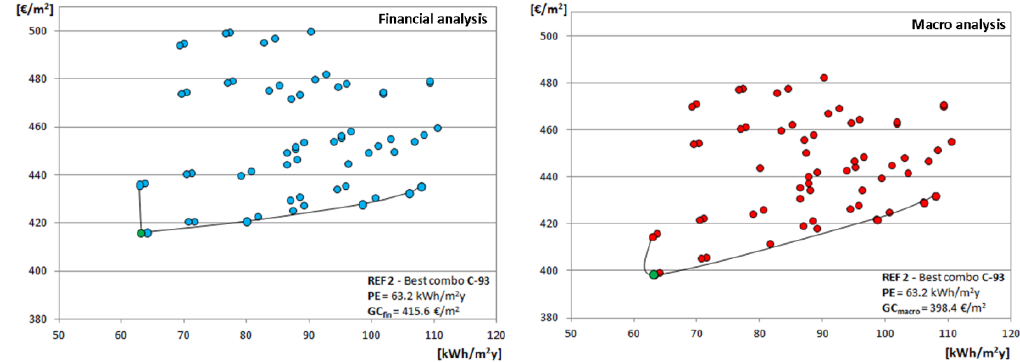
Figure 4. Cost-optimal level of reference building 2 (REF2) obtained from a financial and macroeconomic analysis.